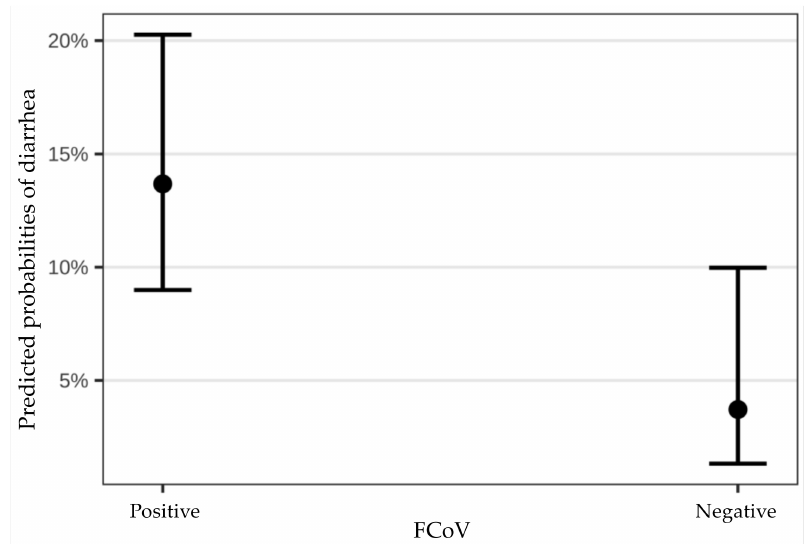
Figure 2. Bootstraps demonstrating the comparison of the risk of diarrhea in cats positive vs. cats negative for feline coronavirus (FCoV) RNA. Black points represent the mean, 95% confidence intervals are